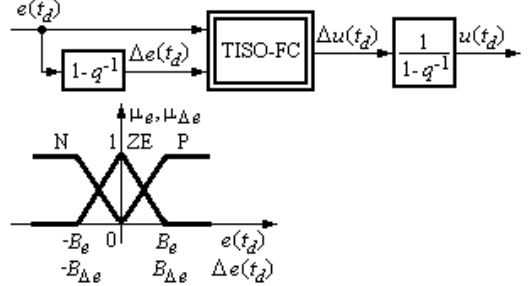
Figure 2. Structure and input membership functions of the Takagi-Sugeno proportional-integral- fuzzy controller.